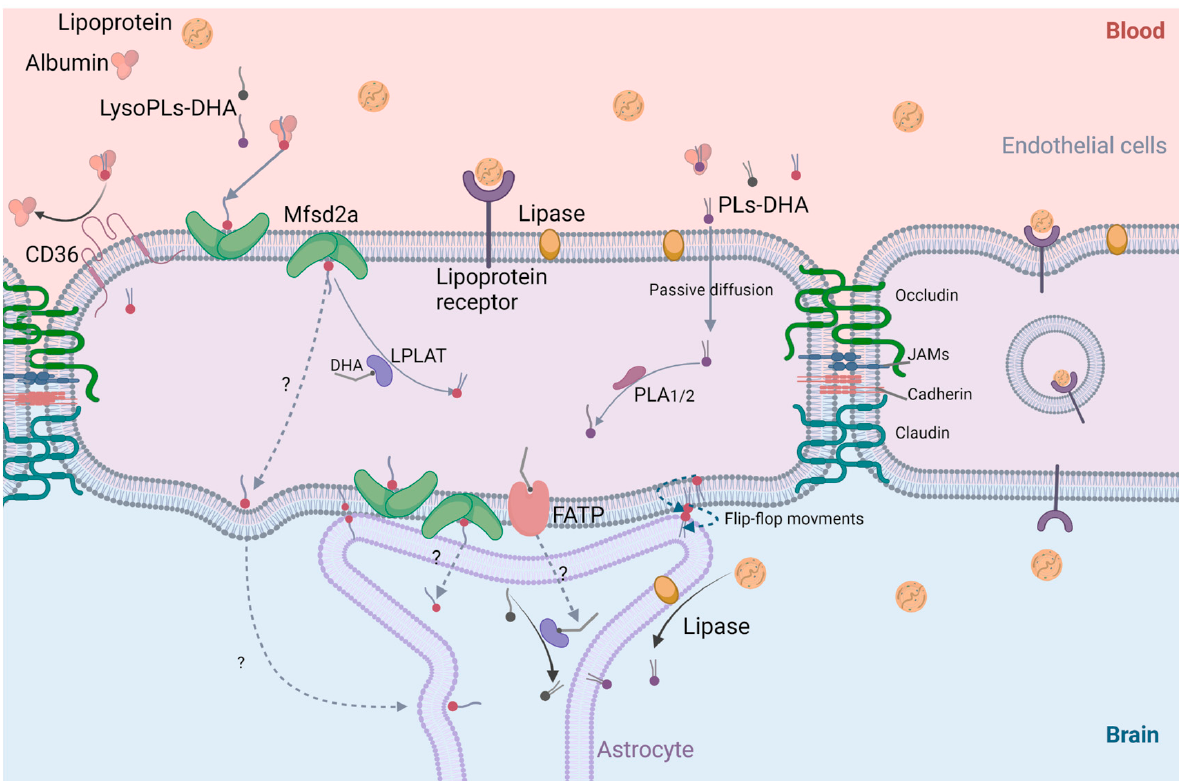
Figure 10. Mechanisms of PLs-DHA and Lyso-PLs-DHA passage across BBB. Mfsd2a: major facilita- tor superfamily domain-containing protein 2; CD 36: cluster of differentiation 36; FATP: fatty acid transport protein; PLA: phospholipase A; LPAT: lysophospholipase acyl transferase; DHA: docosa- hexaenoic acid; LysoPLs-DHA: lysophospholipids carrying DHA; PLs-DHA: phospholipids carrying DHA; JAM: junctional adhesion molecule (Created with BioRender.com accessed on 7 January